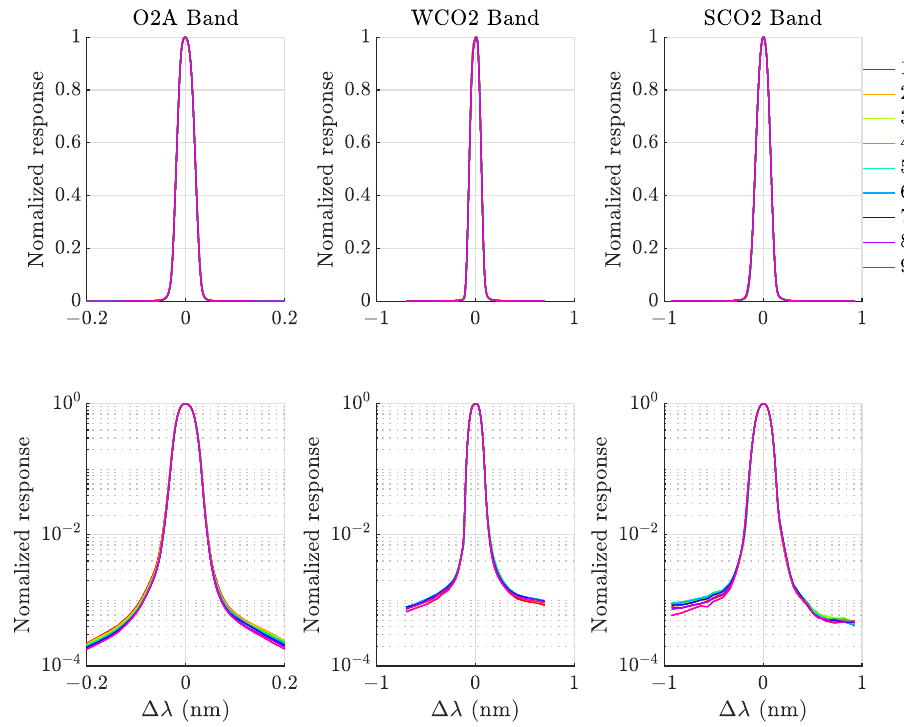
Figure 2. Examples of tabulated preflight ILS of TanSat for the O2A band (pixel 620 in spectral direction, ∼ 768.6 nm), WCO2 band (pixel 240, ∼ 1608.8 nm), and SCO2 band (pixel 240, ∼ 2060.3 nm) (upper panel). The lower panel depicts the same but in log y scale. Nine footprints are shown in different